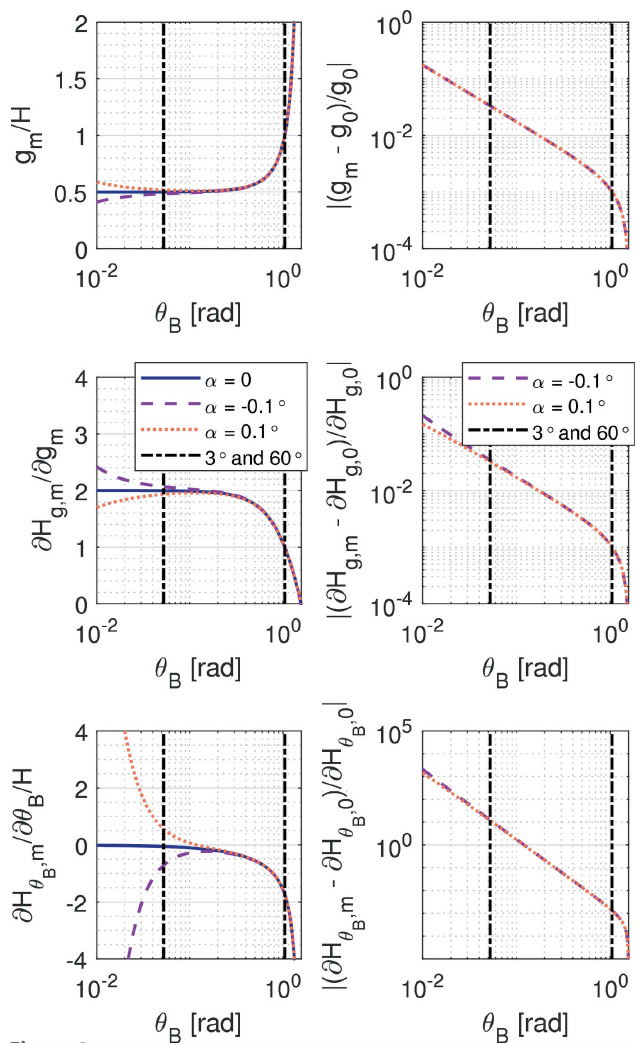
Figure 2 Gap g and offset H dependences on the Bragg angle (cid:2) B for the DCM geometry of Fig. 1, including representative miscut manufacturing limitations, i.e. crystals with small asymmetric cut angles (cid:5) . The quantities of interest are shown on the left and the relative ratio with respect to the nominal case on the right. The (cid:2) B axis is shown in logarithmic scale to highlight the contribution of the miscut at lower angles (higher energies). The HD-DCM angular limits are represented by the vertical dash-dotted lines at 3 (cid:5) and 60 (cid:5)